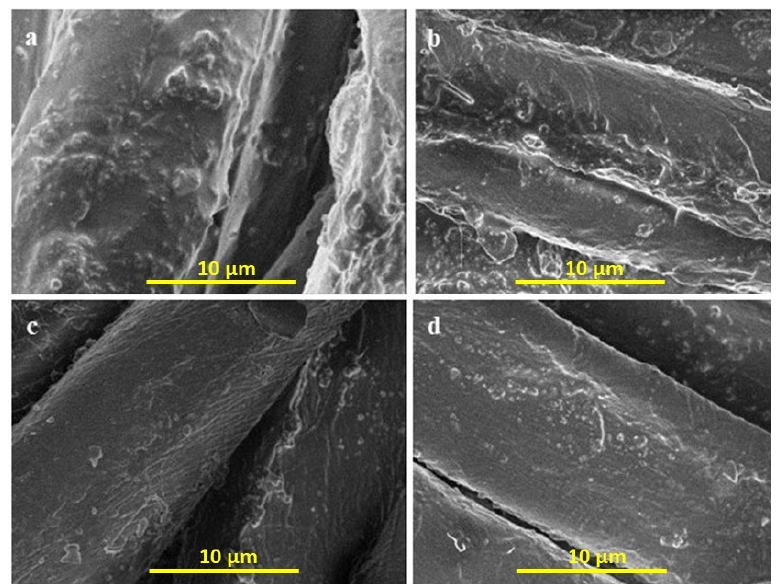
Figure 1. SEM images of coated cotton fabrics ( a ) unwashed sample ( b ) after 5 washing cycles. ( c ) after 10 washing cycles ( d ) after 20 washing cycles.